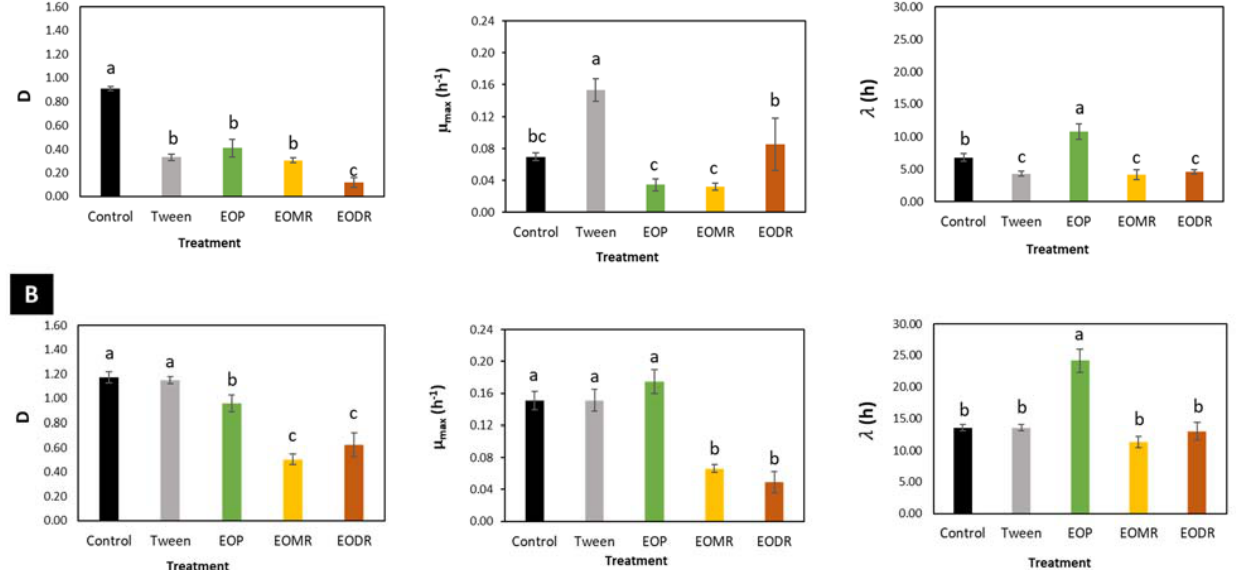
Figure 3. The effects of essential oils from crude organic propolis (EOP) and from its moist residue (EOMR) and dry residue (EODR) on the maximal bacterial culture density ( D ), maximum specific growth rate ( µ max ), and lag phase duration ( λ ) of E. coli ( A ) and L. plantarum ( B ). Columns with different letters indicate statistically significant differences ( p < 0.05). Vertical bars represent the standard deviation.